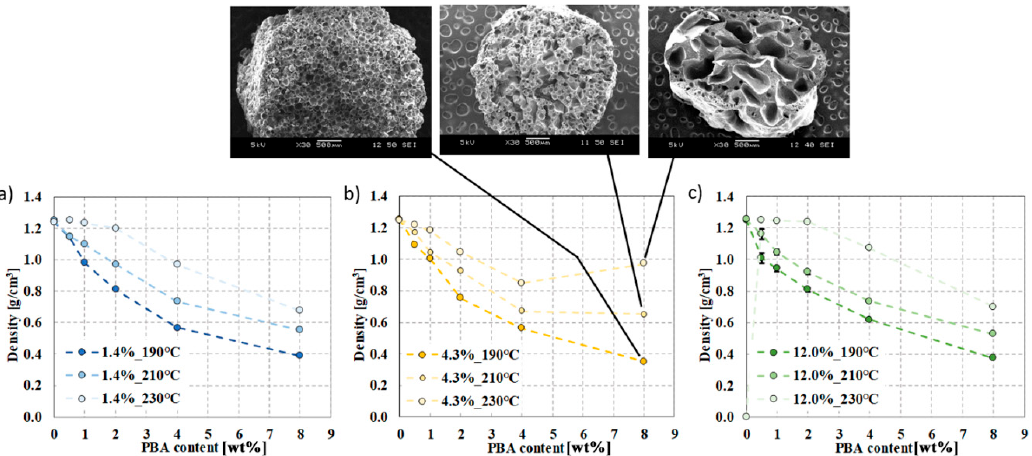
Figure 8. Density of foam structures at 190 °C, 210 °C, and 230 °C, with a D -lactide content of the matrix of ( a ) 1.4%, ( b ) 4.3%, ( c ) 12.0%.